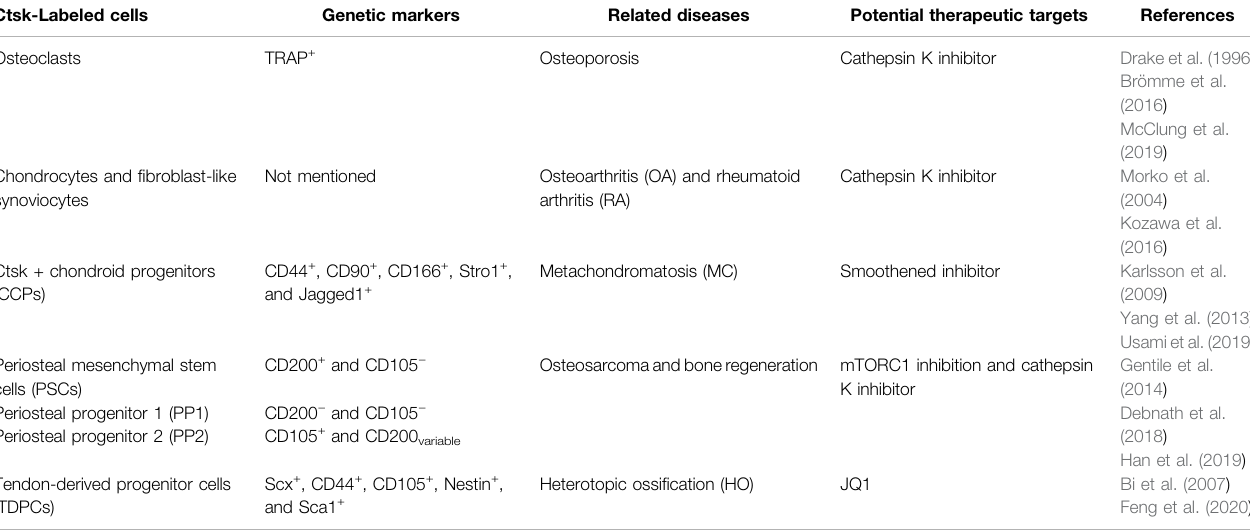
TABLE 1 | Genetic markers of Ctsk-labeled cells and related diseases in the skeletal